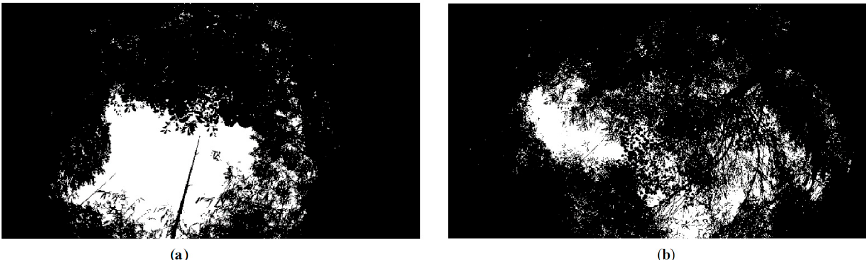
woodland and was misclassified as